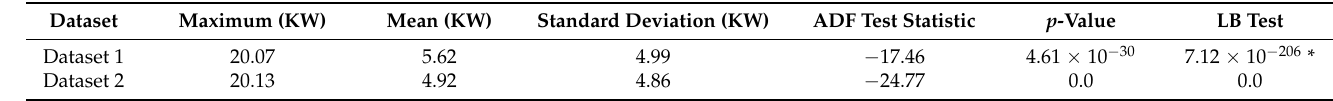
Table 1. Statistical information description of the PV power dataset.